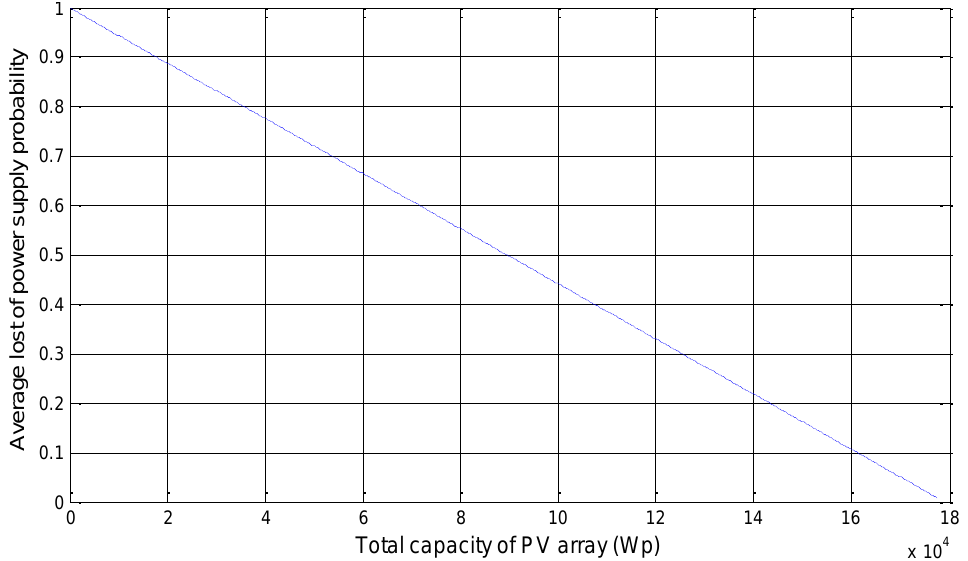
Figure 8 . Variation of total PV capacity versus average loss of power supply